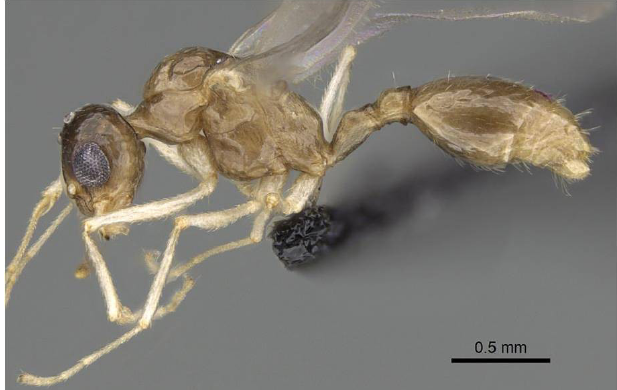
Fig 11 . Temnothorax ansei sp.n. male in lateral view. Photo credit: Michele Esposito, from www.AntWeb.org, CASENT0919954_P_1, published with permission.